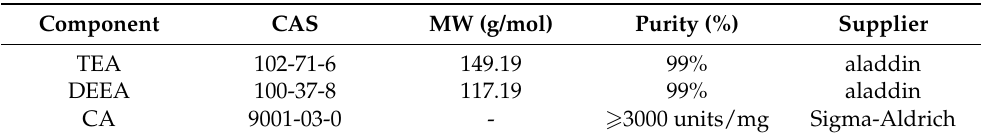
Figure 1. Molecular structure of: ( a ) triethanolamine (TEA) and ( b ) 2-(diethylamino)ethanol (DEEA). Table 1. Chemicals